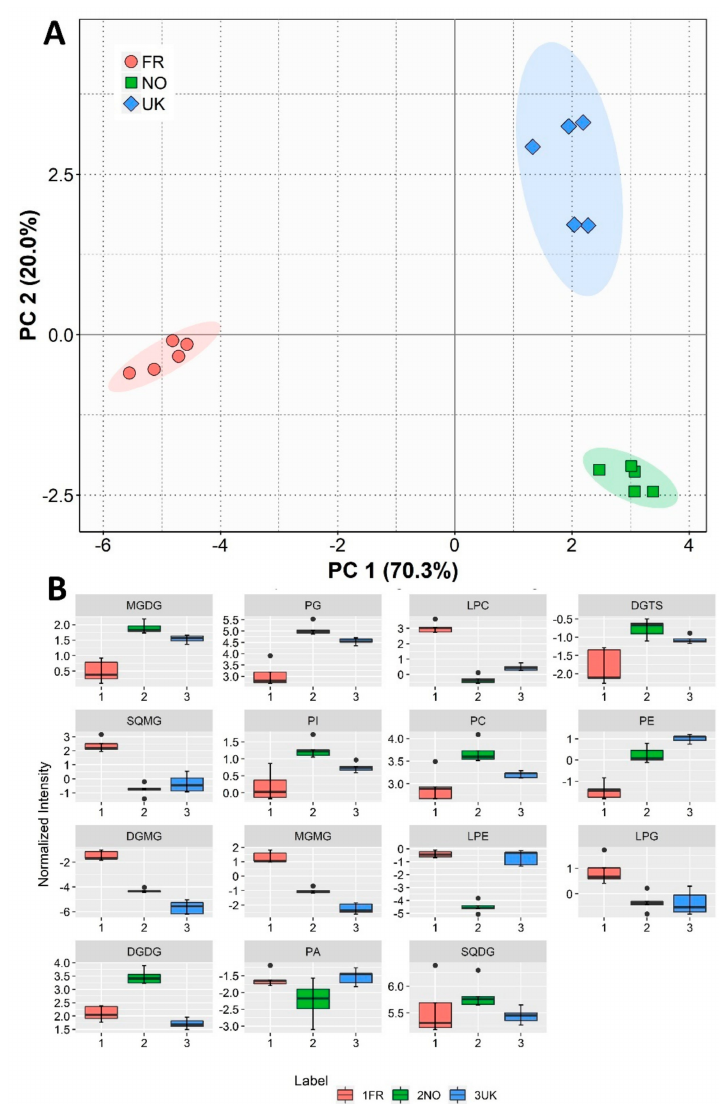
Figure 3. Sample origin discrimination with regard to polar lipid class content. ( A ) Principal component analysis (PCA) score plot of lipid class totals (sum of normalized peaks for each lipid class) of Saccharina latissimi samples from di ff erent origins (FR—France, NO—Norway, UK—United Kingdom). ( B ) Box plots for the lipid classes present in S. latissimi samples from di ff erent origins, ranging from major to lesser contributors for Principal Component 1 of the